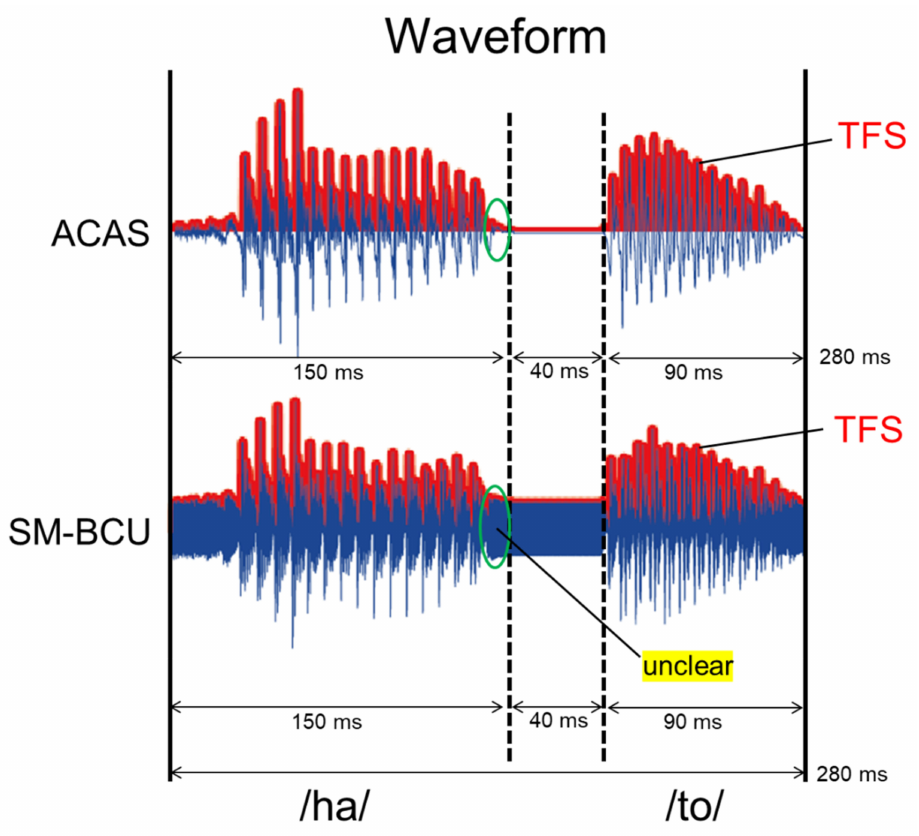
Figure 5. Envelope of 280 ms speech signal for ACAS and SM-BCU. ACAS, air-conducted audible sound; SM-BCU, speech-modulated bone-conducted ultrasound; TFS, temporal fine